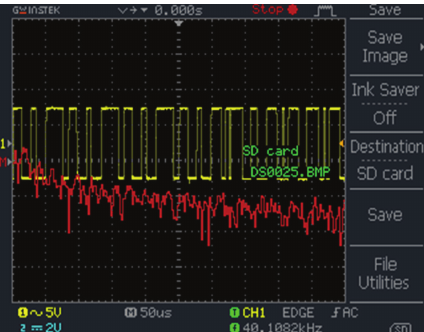
Figure 7: Chaotic